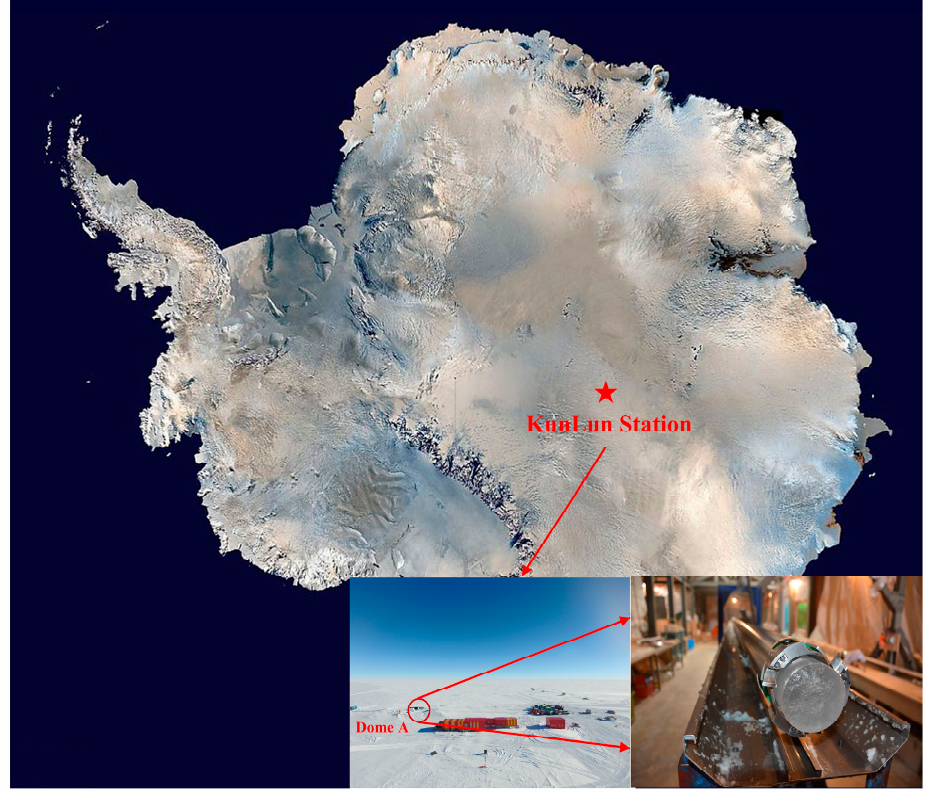
Figure 3. Drilling site of the first Chinese deep ice-core drilling project, DK-1, at Dome A, Antarctica.